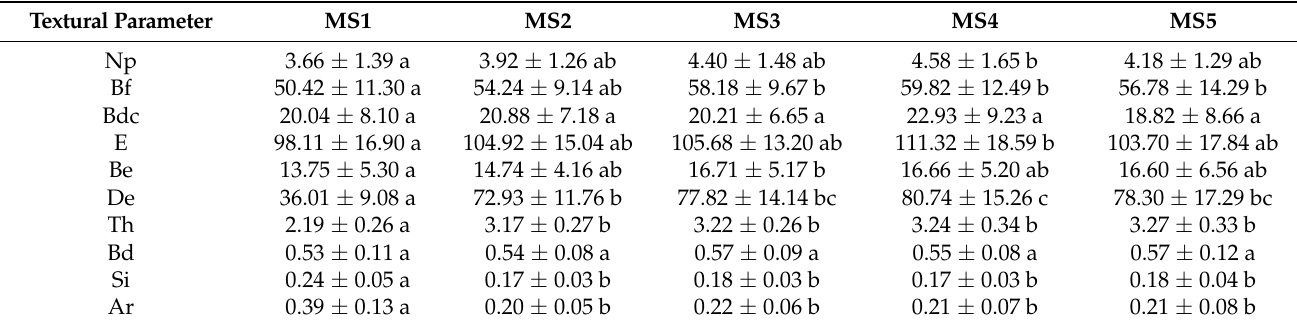
Table 5. Means and standard deviations of the instrumental textural parameters by maturity stage (MS) established by DigiEye ®1